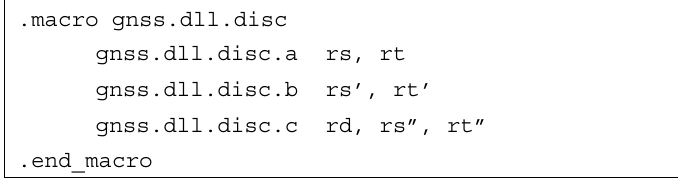
Figure 7. Code discriminator instruction macro.